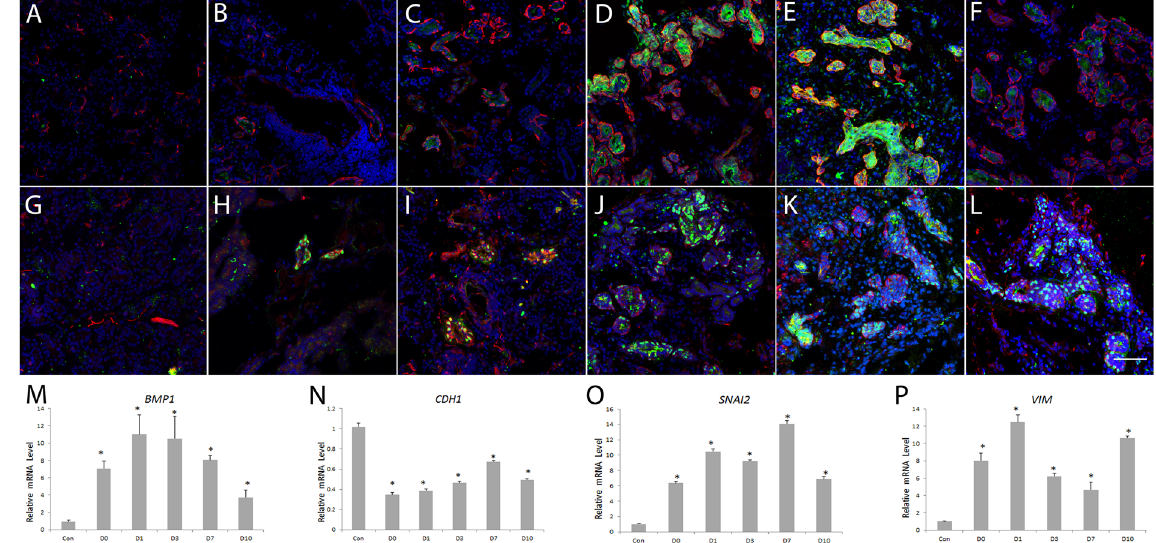
Figure 6. EMT-associated markers in lacrimal gland tissues after duct ligation-induced injury and ligature release. Double staining on control lacrimal gland ( A , G ), and samples 0 ( B , H ), 1 ( C , I ), 3 ( D , J ), 7 ( E , K ) and 10 (F , L ) days post-reopening of the main excretory duct showed colocalizaion of Vimentin (red, A – L ) with epithelia proliferation markers K14 (green, A – F ) and ∆ Np63 (green, G – L ) during tissue repair. Blue is DAPI staining. Bar represents 100 μ m. RT-qPCR showed that BMP1 ( A ), CDH1 ( B ), SNAI2 ( C ), and VIM ( D ) mRNA levels dramatically changed after main secretory duct ligation and reopening ( * P <